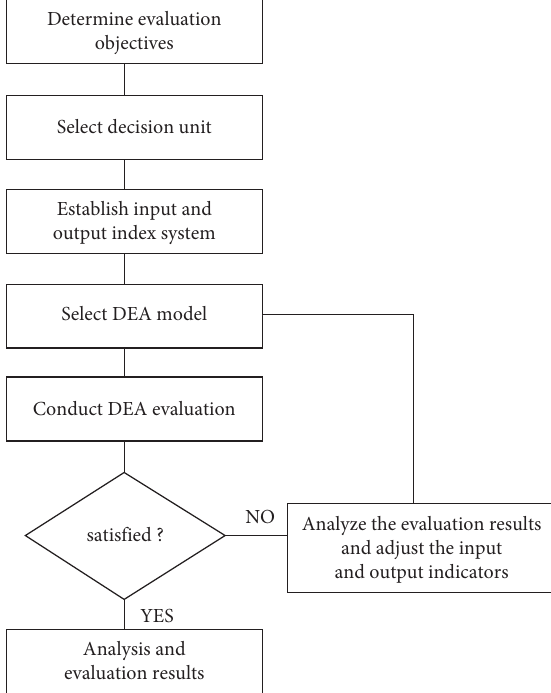
Figure 1: Calculation flow of the DEA